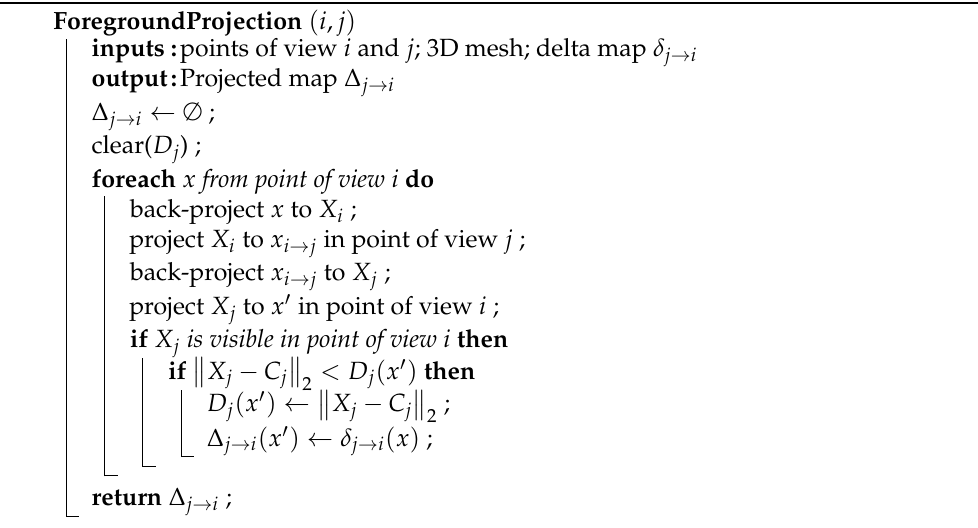
Algorithm 3: Pseudo-code of our foreground projection